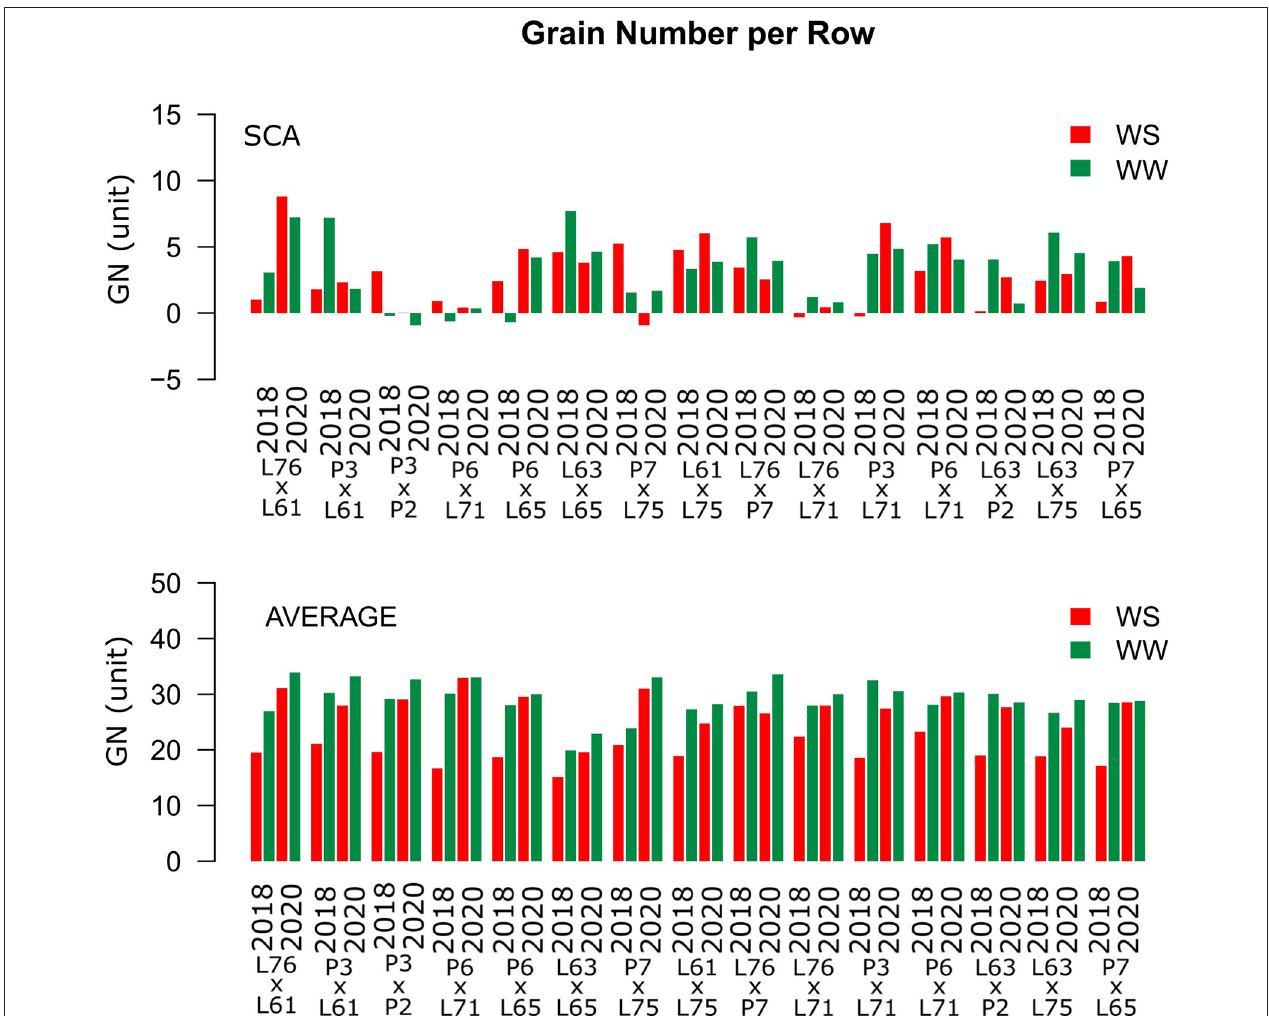
FIGURE 5 | Estimation of the SCA and GN mean values for popcorn hybrids evaluated under two WCs and crop seasons in 2018 and 2020. WS is represented by red bars and the WW is represented by dark-green bars.